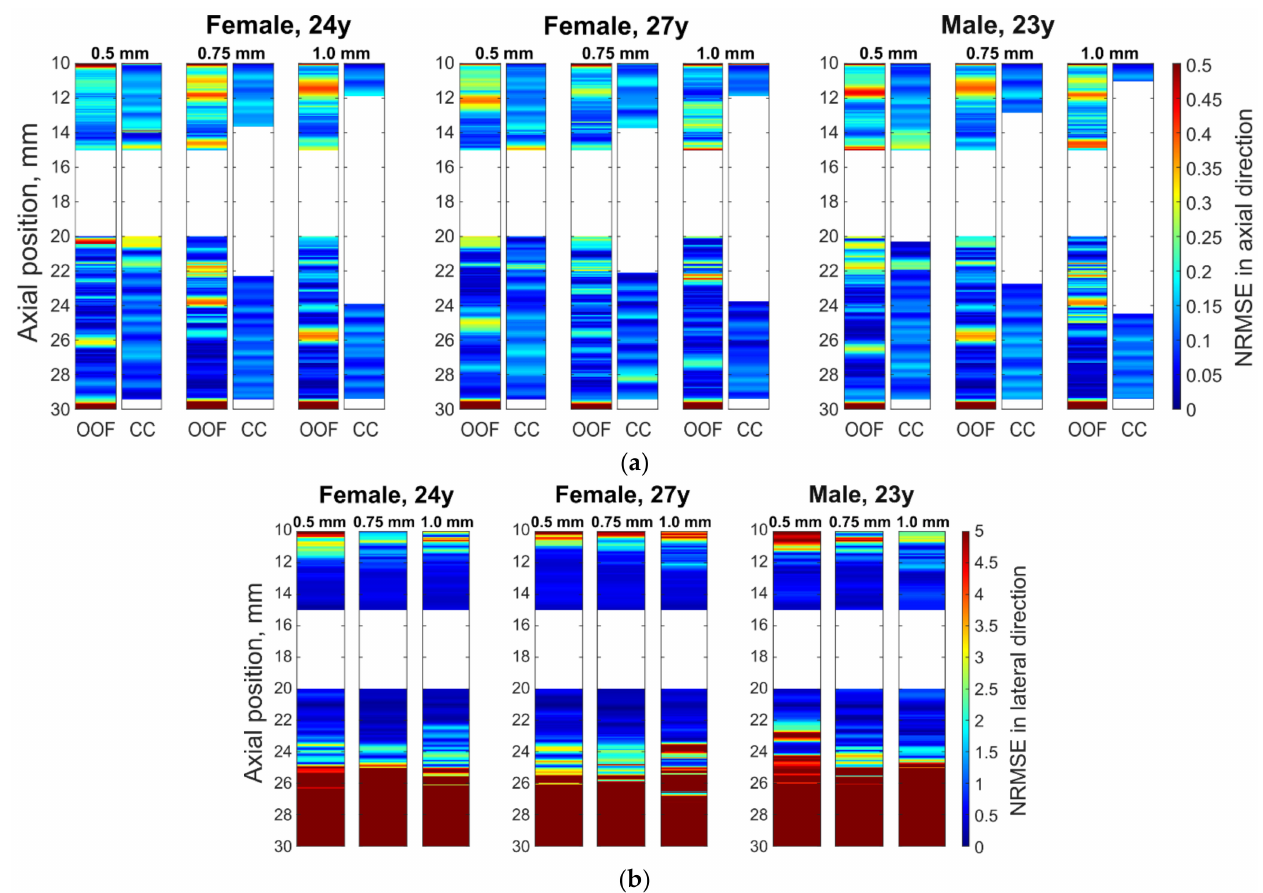
Figure 12. Normalized root mean square errors (NRMSEs) between theoretically defined and esti- mated motion in the midline of the scanning plane: ( a ) radial errors in the axial direction; ( b ) longitu- dinal errors in the lateral direction. ( a , b ) Sub-images: three blocks are the estimation errors for the model with three different defined waveforms (of 24 year old female, 27 year old female, and 23 year old male) with columns for maximal peak-to-peak amplitudes of 0.5, 0.75, and 1 mm, respectively. The motion was estimated in the axial direction by 1DCC and by OOF algorithm; motion in lateral direction by the OOF